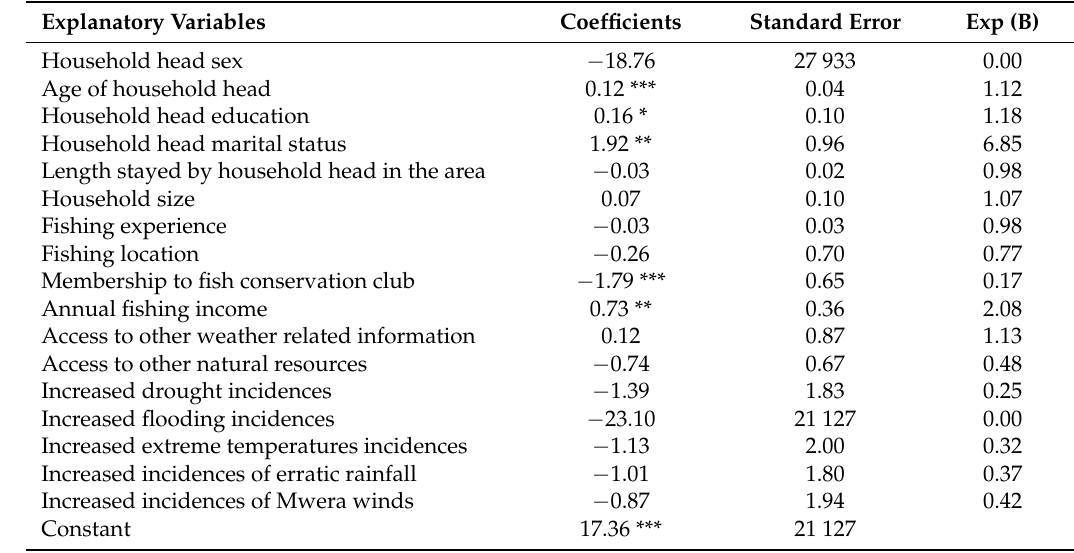
Table 3. Binary logistic regression analysis results of factors influencing Nkhotakota fishers’ ( n = 108) ability to cope with perceived fish catch